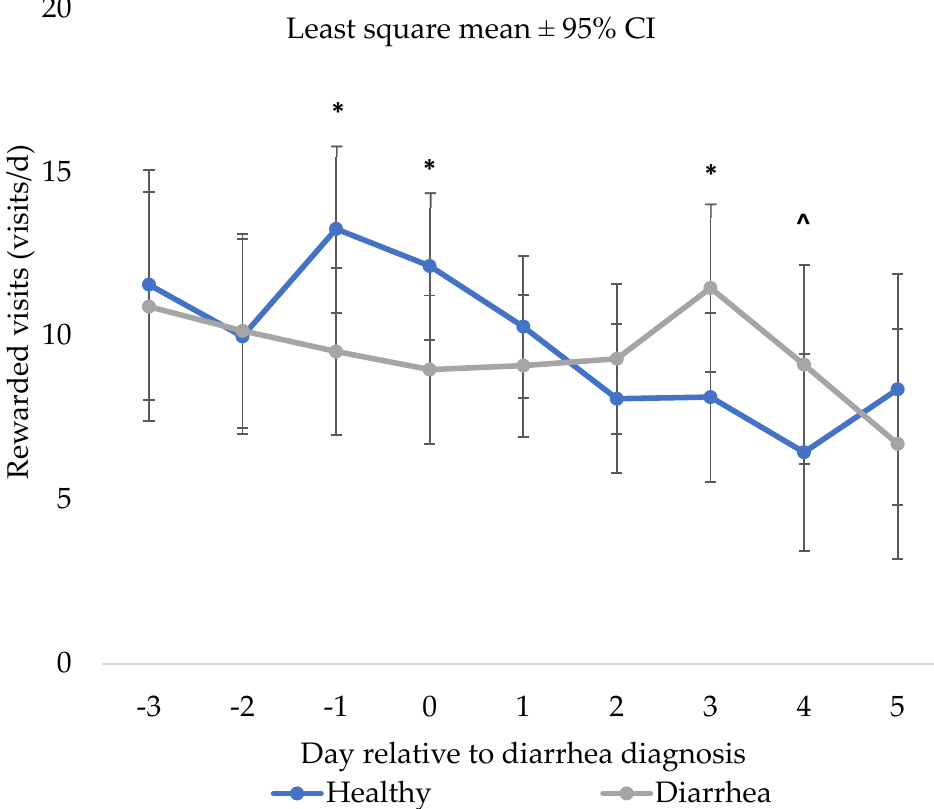
Figure 3. Results of the repeated measures mixed linear regression model assessing the relationship between day relative to neonatal calf diarrhea diagnosis (day 0) and least square mean rewarded visits (visits/d) of pair matched control ( n = 31) and diarrhea ( n = 31) calves fed by an automated milk feeder, preweaning. A calf was defined as having NCD if they had a fecal consistency score of 2 or 3 (runny to watery consistency) for two or more consecutive days. Calves were matched on farm, gender and age and the model included calf and pair number to account for the matched pair analysis. The error bars represent ± 95% confidence interval. * Indicates a significant difference ( p ≤ 0.05), and ^ indicates a tendency (> 0.05 p < 0.10).